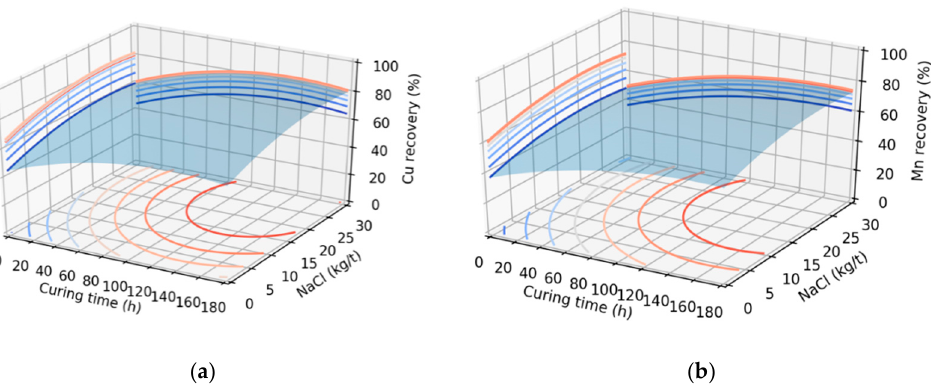
Figure 4. Response surface for Cu ( a ) and Mn ( b ) recovery as function of the independent variables curing time and NaCl concentration.